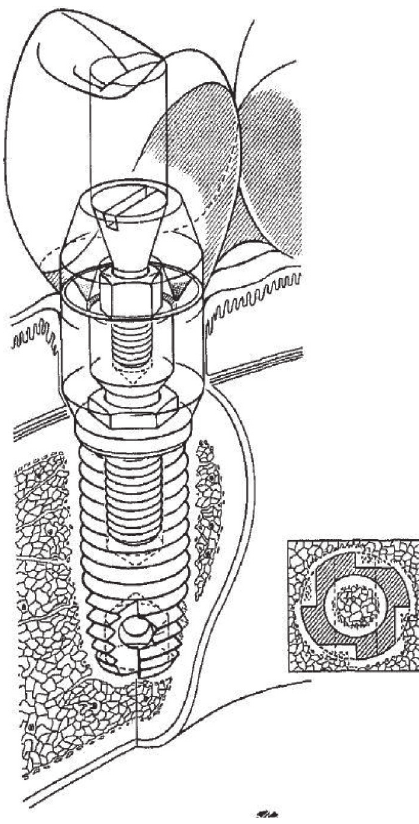
Figure 3: Br˚anemark-style dental osseointegration. Schematic shows a titanium implant with a screw fixation design. There are three components of this style of implant: 1, a titanium post that achieves osseointegration with the jaw; 2, abutment that screws into the post and remains smooth and motionless at the gingiva; and 3, the crown that is designed to match the patient’s tooth (figure adapted with permission from Adell R. Lekholm U. Rockler B.